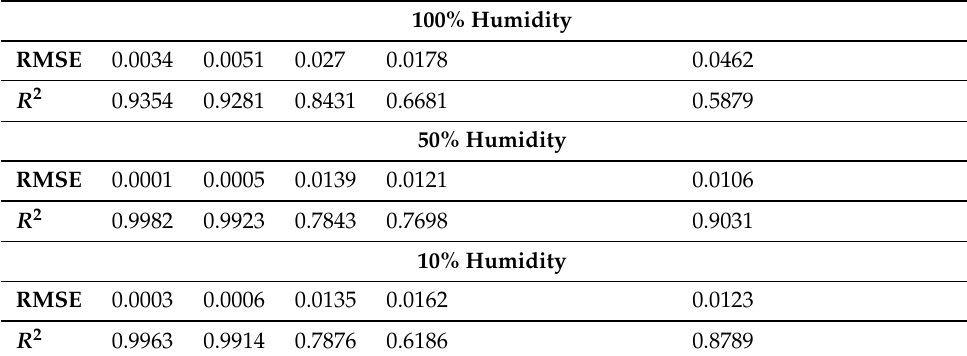
Figure 9. KNN model with various humidity levels. Table 7. Results of KNN method.